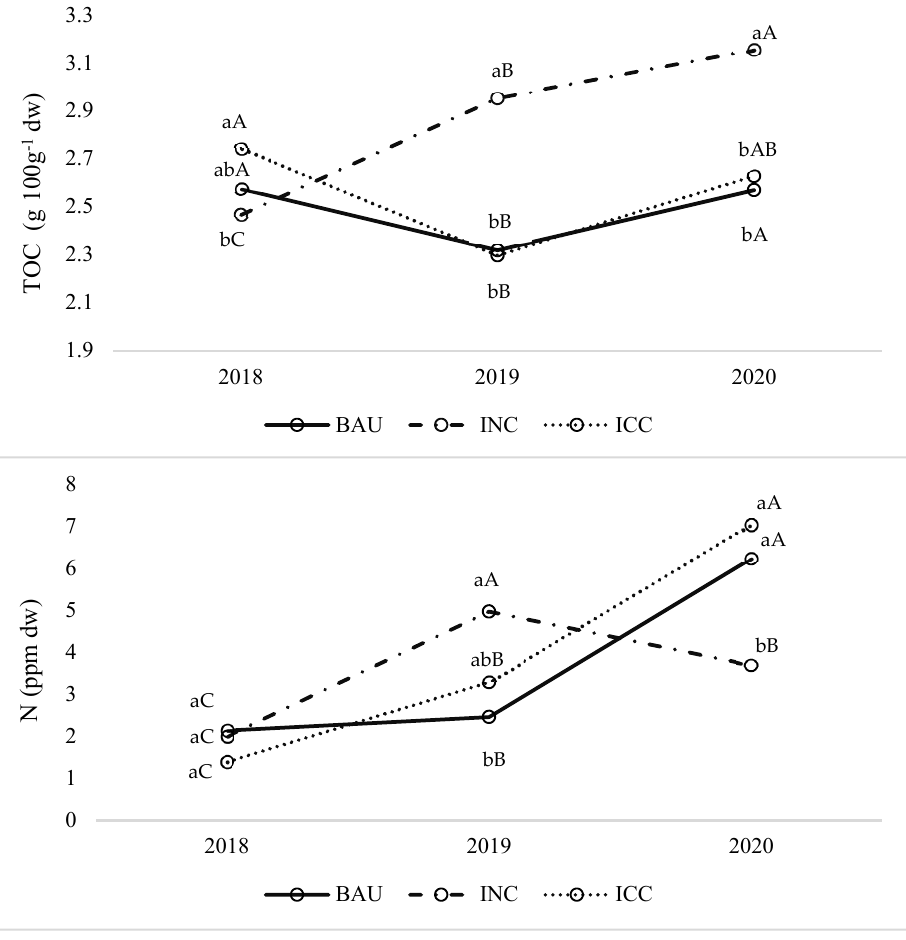
Figure 1. Soil total organic carbon (TOC) and total nitrogen (N) variability among the different system management during the three years. Legend: Values belonging the same parameters without common letters are statistically different according to Kruskal Wallis test ( p < 0.05). Upper case letters refer to differences among years for each treatment; lower case letters refer to differences among treatments within the same year.